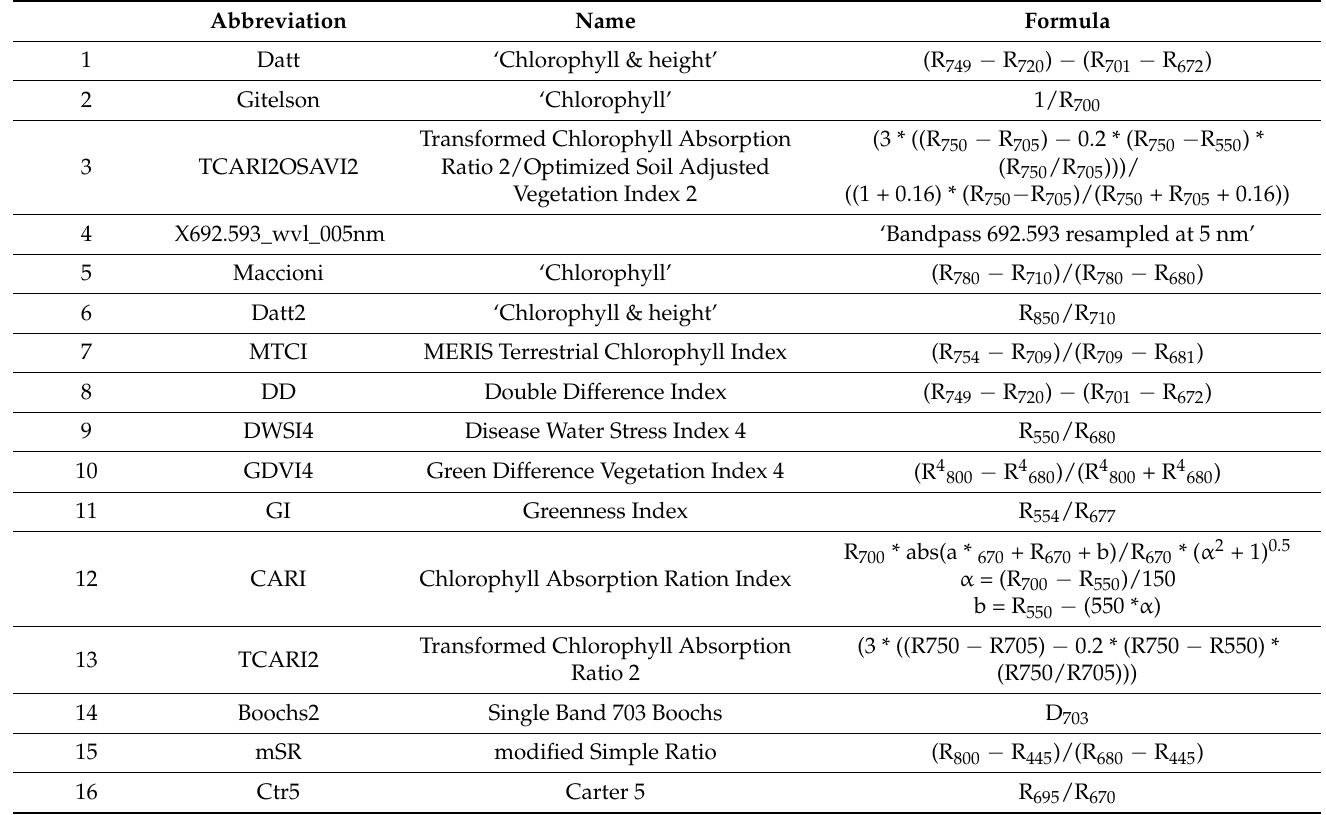
Table 3. Top 20 predictor variables used in the global water potential model with description and band